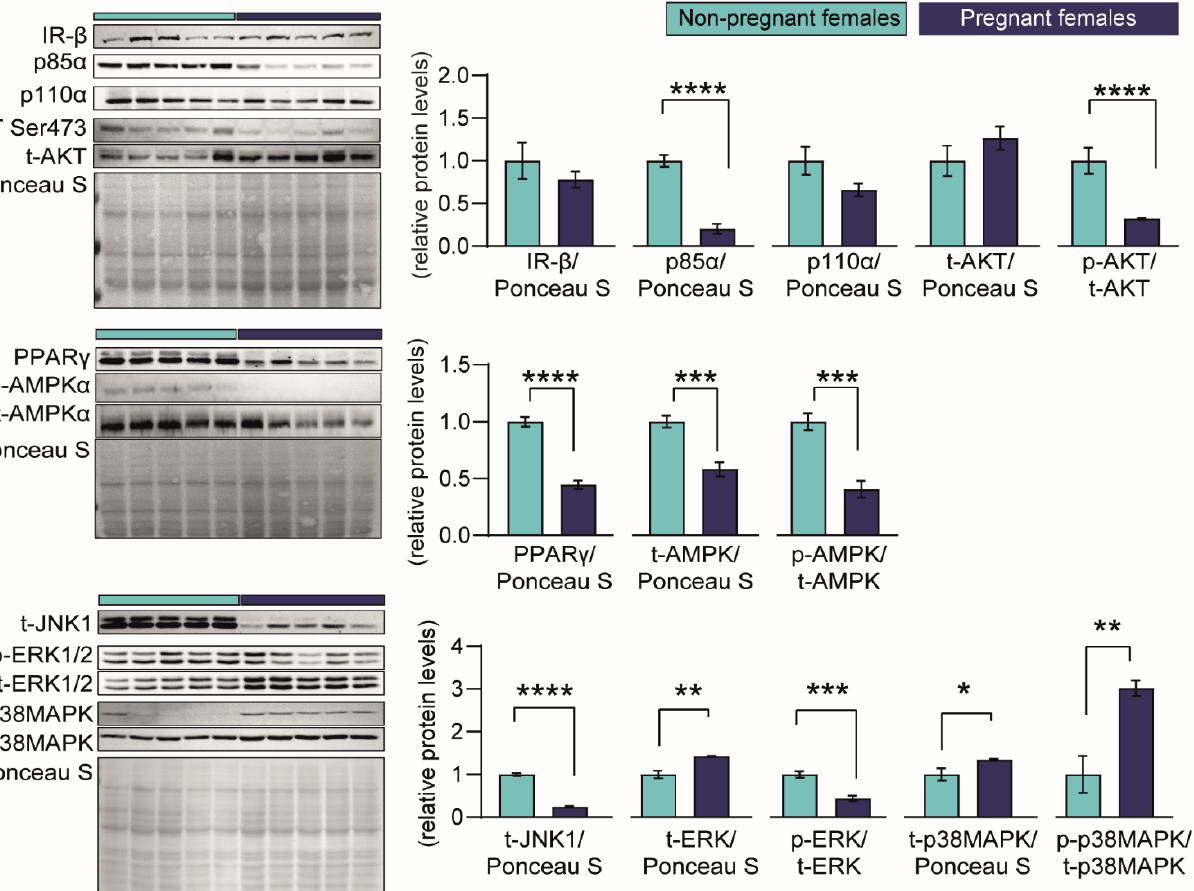
Figure 4. Abundance of proteins in growth ‐ signalling pathways and expression of cell ‐ cycle reg ‐ ulatory genes in the kidney in response to pregnancy in mice. ( A – C ) Immunoblots and quantifi ‐ cation of PI3K ‐ AKT, PPAR ‐ AMPK and MAPK ‐ JNK signalling proteins in the kidneys of non ‐ preg ‐ nant and pregnant female mice (n = 5/group) ( D , E ). Expression of genes related to cell ‐ cycle pro ‐ gression and mitochondrial ‐ related genes in kidneys of non ‐ pregnant and pregnant female mice (n = 4–5/group). Data are presented as mean ± SEM and were analysed by unpaired Student’s t ‐ test. Asterisks represent significant differences between non ‐ pregnant and pregnant mice (* p < 0.05; ** p < 0.01; *** p < 0.001; **** p < 0.0001).